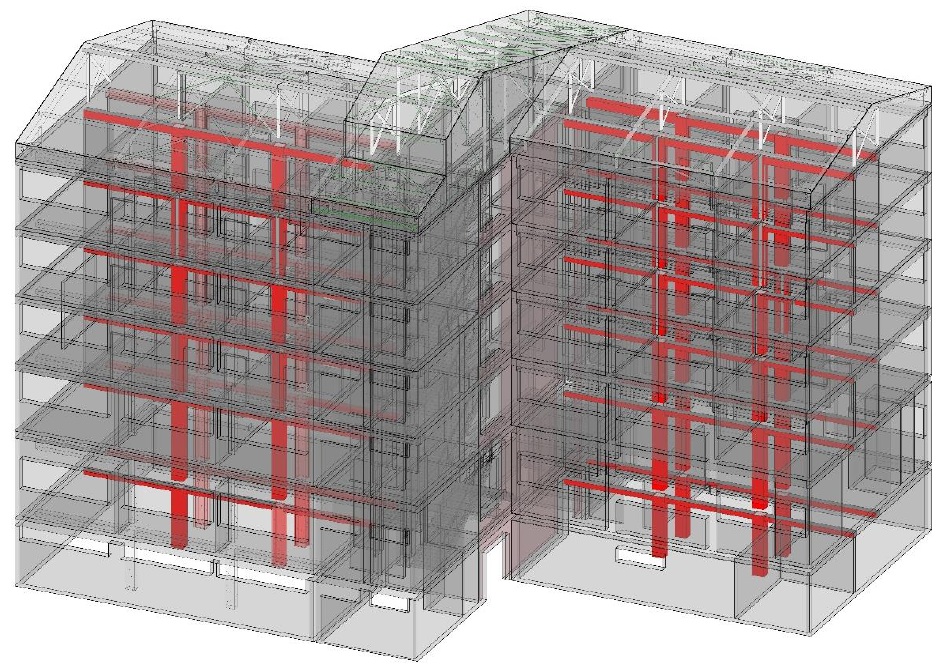
Figure 20. Concrete frames (red) that require FRP jacketing.